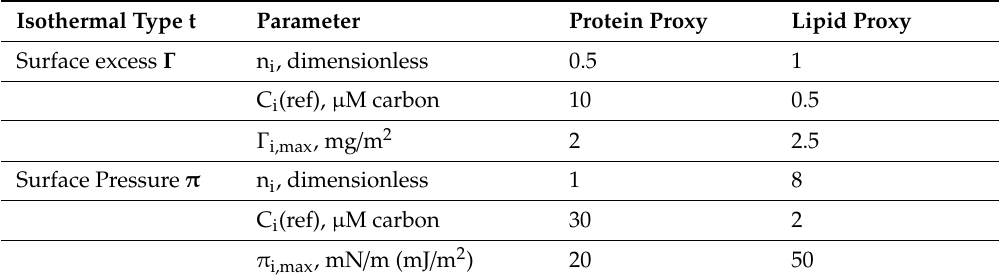
Table 2. Parameter settings drawn from the physical chemical surfactant literature to describe interfacial behaviors of detrital marine organic compounds. Values are inserted into the empirical isotherms to generate π (A( C )) relationships, and thus a planar “equation of state” for the microlayer portion of the aqueous planetary interface. The very high integer dependence of the lipid tangential pressure is a reflection of its “solid” or “crystalline” form in the